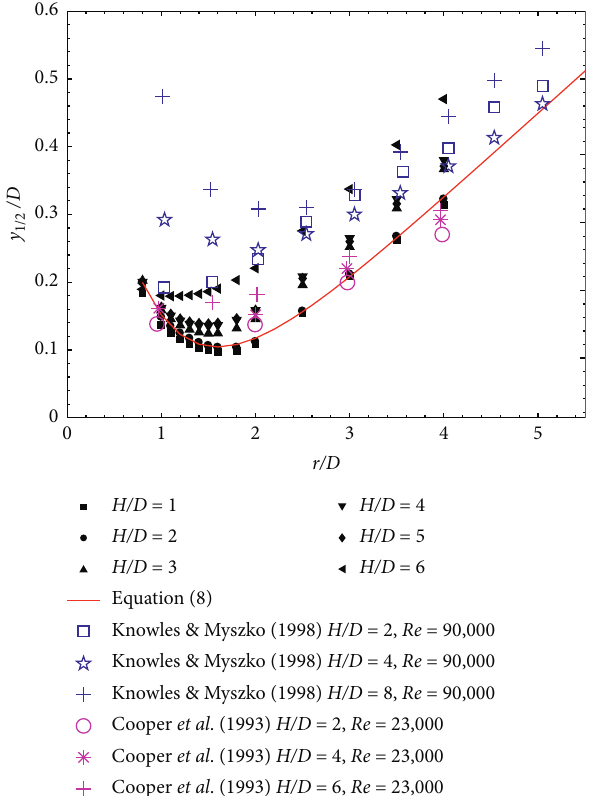
Figure 19: Radial growth of jet half-height for different nozzle heights.